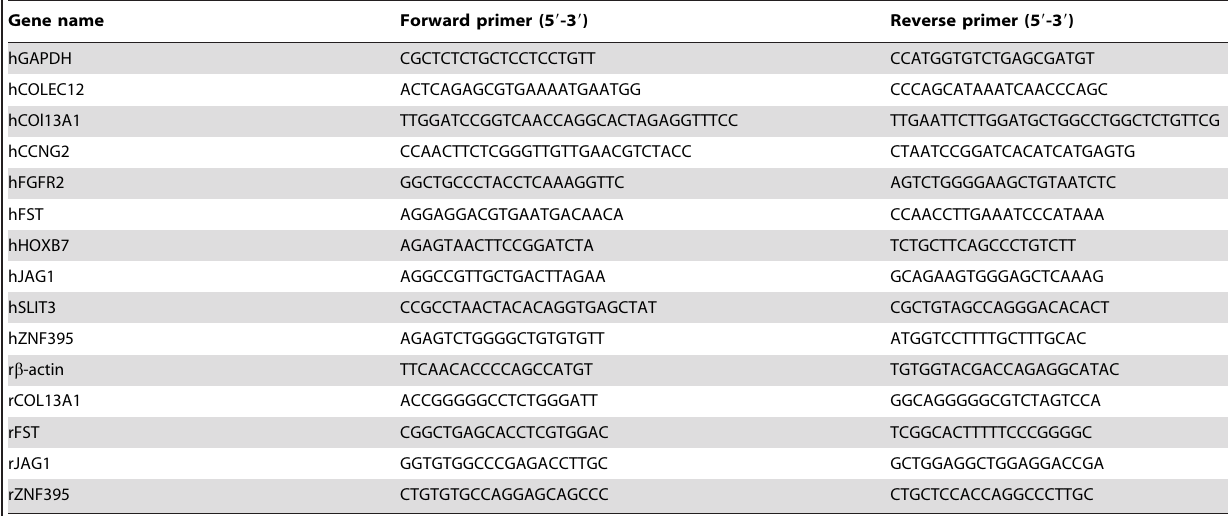
Table 5. qPCR primer